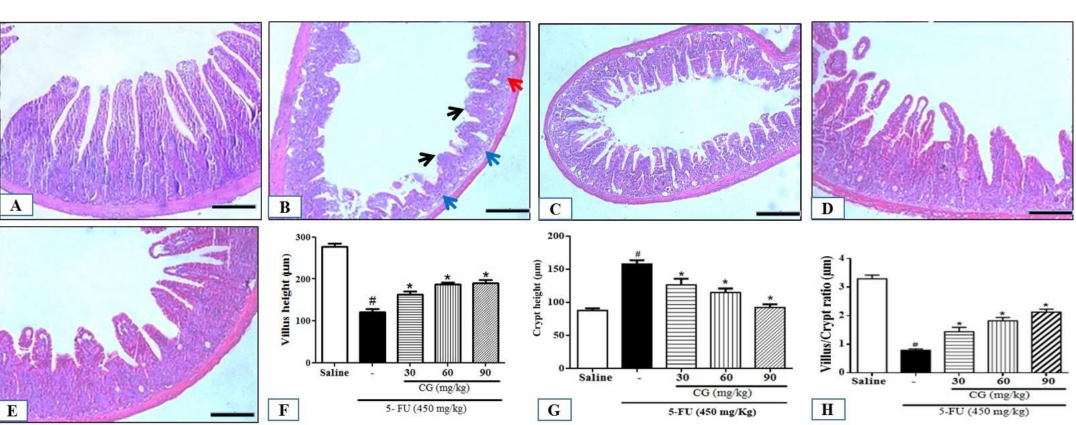
Figure 2. Histopathological analysis. ( A ) Saline; ( B ) 5-FU; ( C ) CG 30; ( D ) CG 60; ( E ) CG 90. 5 FU induced inflammatory cell infiltrate (red arrow), decreased intestinal villi (black arrow), loss of intestinal crypt architecture (blue arrow). Pretreatment with CG (30, 60 and 90 mg / kg) decreased the inflammatory infiltrate and prevented the shortening of the villi ( F ), increased crypt depth ( G ) and decreased villus / crypt ratio ( H ), with greater reversion of the 5-FU e ff ect in the CG 90 + 5-FU group. All panels were obtained on the 100 µ m scale ( × 200). Values were expressed as mean ± SEM. One-way ANOVA followed by the Tukey’s test were used for the statistical analysis was used, where # p < 0.05 vs. saline group and * p < 0.05 vs. group 5-FU. Table 1. Histopathological scores of mice subjected to 5-FU-induced intestinal mucositis and pretreated with CG. Groups Scores Saline 0 (0-0) 5-FU 2 (1-3) # CG 30 3